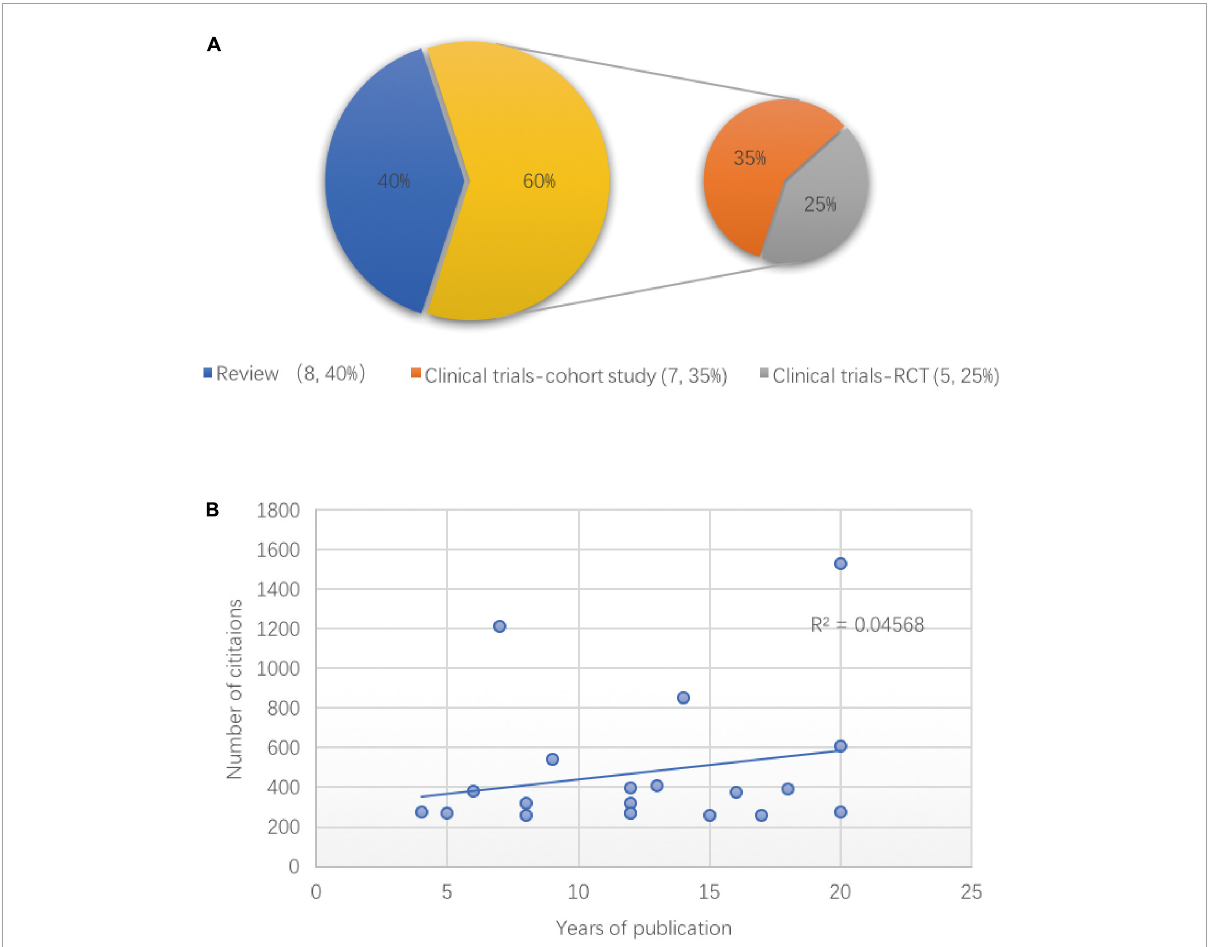
FIGURE6 The classification and correlation analysis of the top 20 cited articles on postoperative delirium (POD). (A) The article types of the top 20 cited articles on POD, randomized controlled trial (RCT). (B) Linear correlation between the years of publication and numbers of citations among the top 20 POD